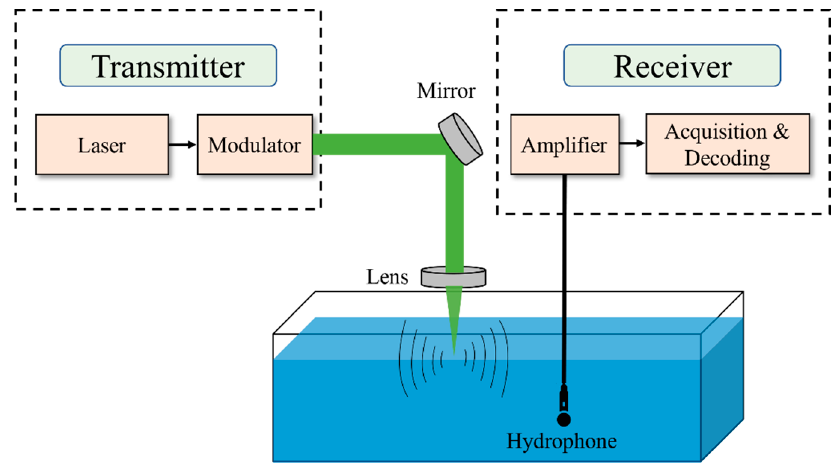
Figure 13. General block diagram of air to underwater photoacoustic communication. Table 2. Experimental results of range and sound pressure level for different modulation techniques using linear photoacoustic